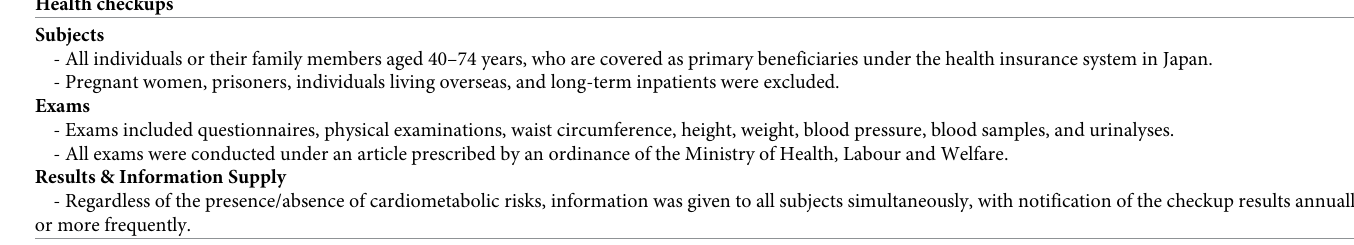
Table 1. Nationwide preventive program: Screening and lifestyle intervention features. Health